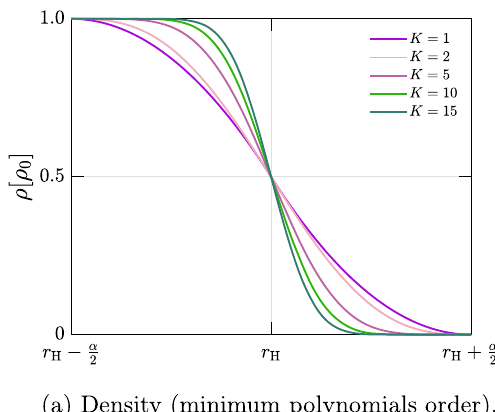
Fig. 2 The axis are as in Fig. 1, where here is shown the solution with minimum order N of each density polynomial (8) for various values of K which is the maximum order of the derivative of density that is